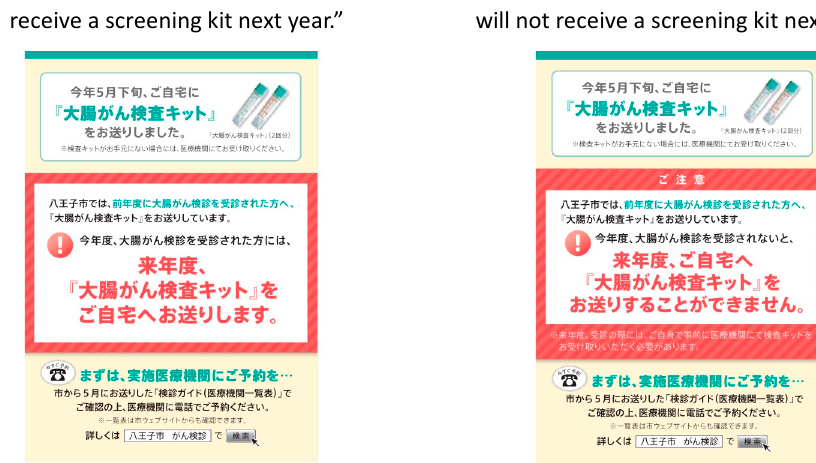
Figure 2. Two messages to remind citizens about the colorectal cancer screening.